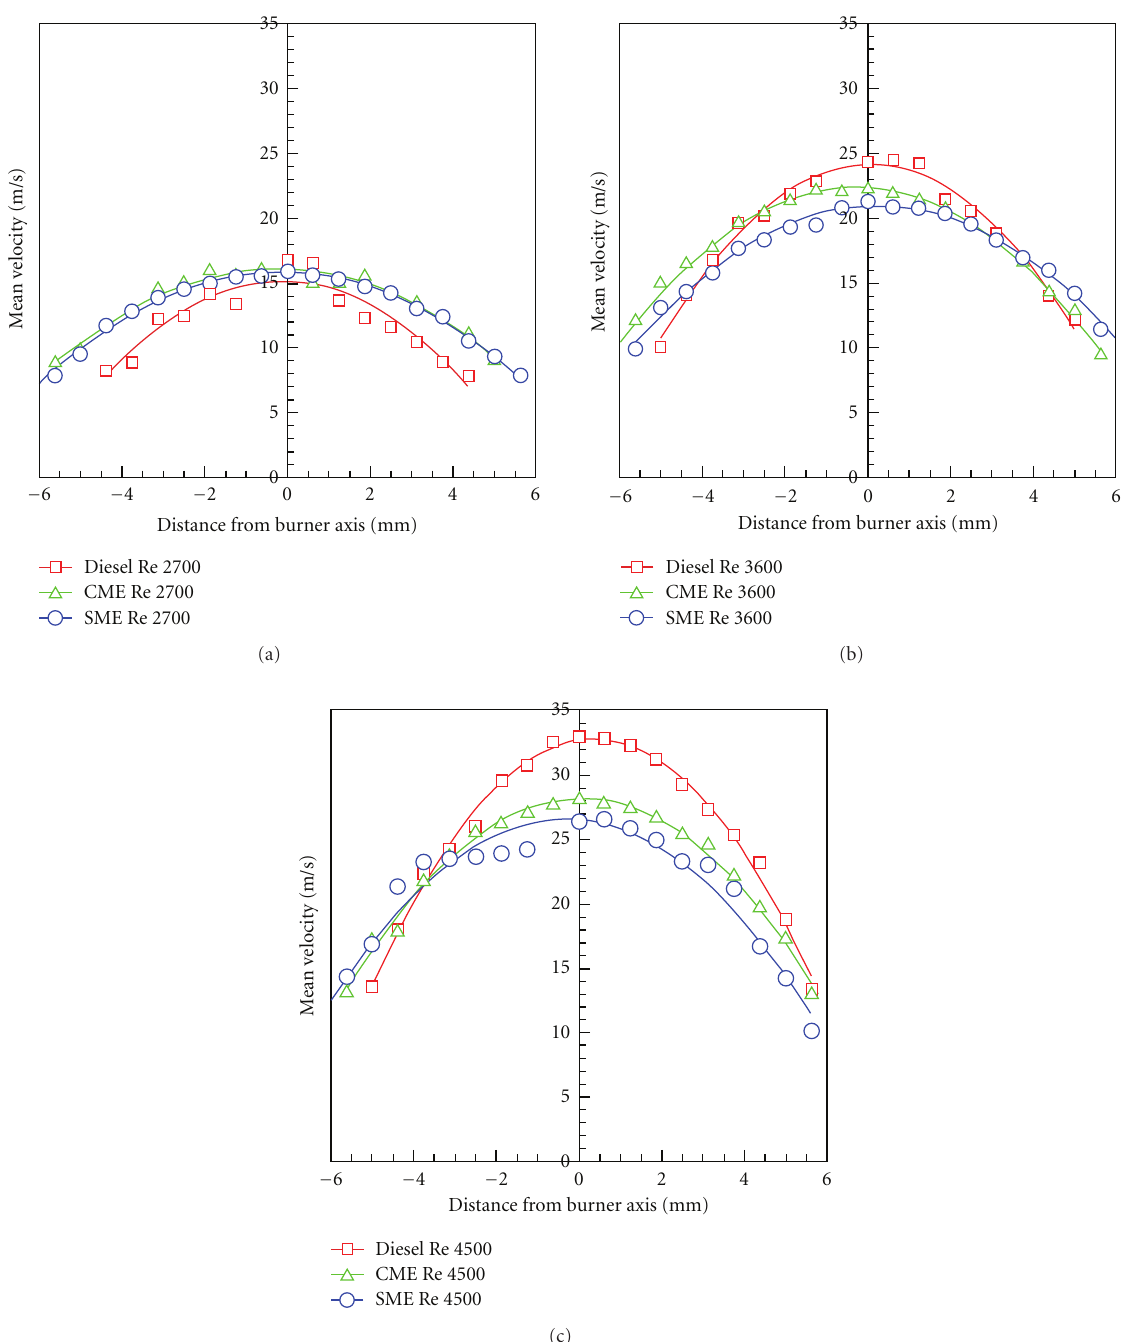
Figure 5: Mean axial velocity profiles at the burner